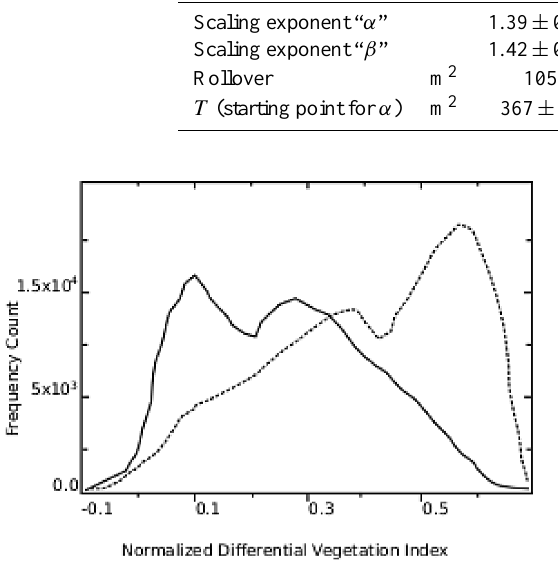
Figure 8. Distribution of NDVI values in the areas covered by the two original event inventories. Dotted line shows the photo- interpreted (PI) inventory portrayed in Fig. 3a. Continuous line shows the semi-automatic (SA) inventory shown in Fig.